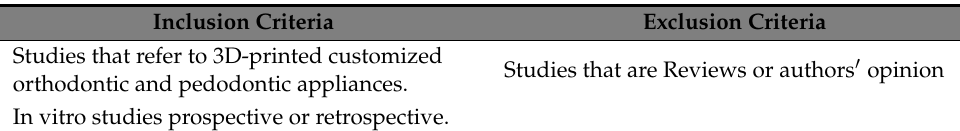
Table 2. Inclusion and Exclusion